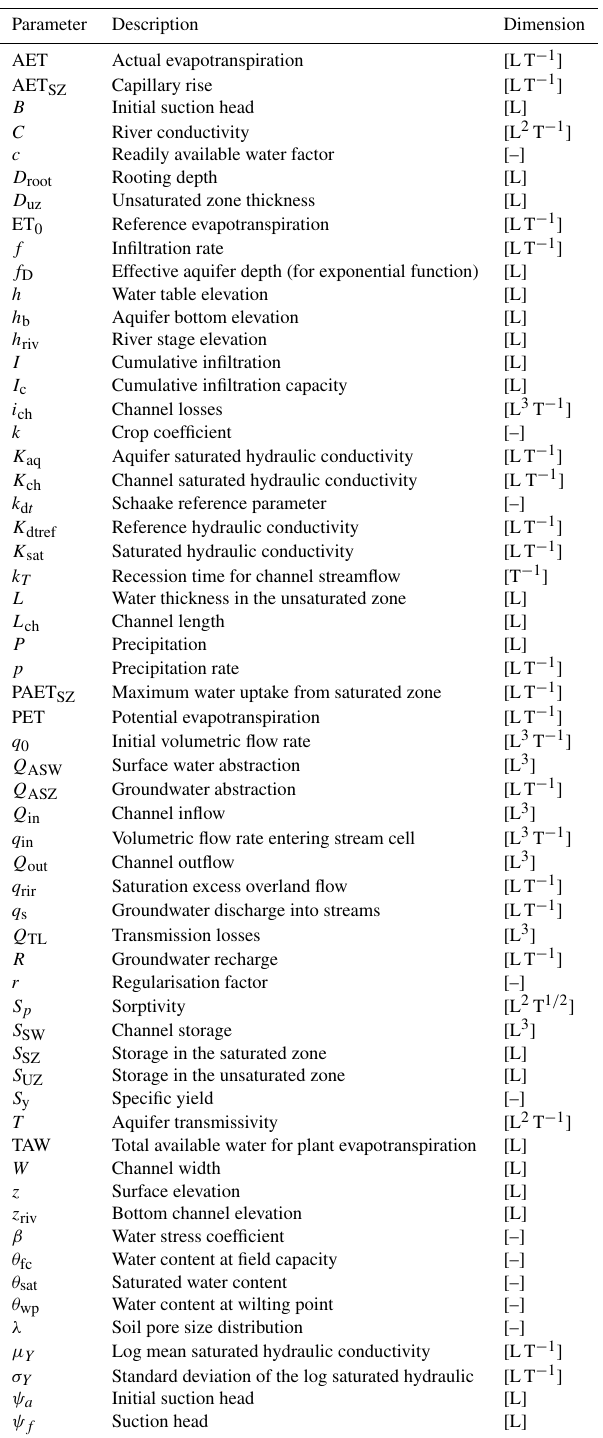
Table A1. List of parameters and model